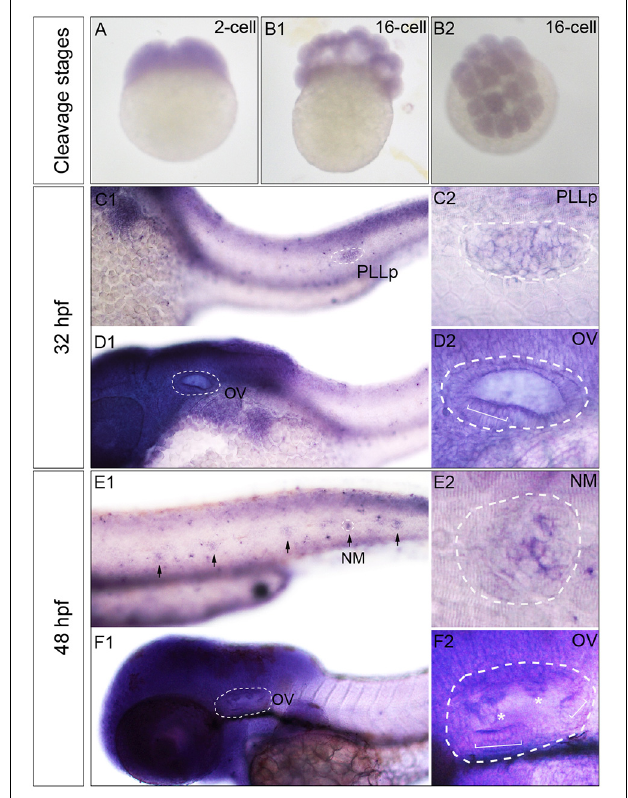
FIGURE 1 | Transcription patterns of Phf8 from 2-cell stage to 48 hpf. (A,B) Phf8 expression was detected in both blastomeres at the 2-cell stage and in whole blastoderm at 16-cell stage. (C–F) Expression of Phf8 in PLL system and otic vesicle at 32 and 48 hpf. ( C1,C2 ; PLLp, 32 hpf), neuromasts ( E1,E2 ; NM, 48 hpf), and otic vesicle ( D1,D2 , F1,F2 ; OV, 32 and 48 hpf). Black arrows indicate the deposited neuromast, the white asterisks show protrusions of the semicircular canal, and the white square bracket shows the cristae. PLL primordium, PLLp; Neuromast, NM; otic vesicle, OV.